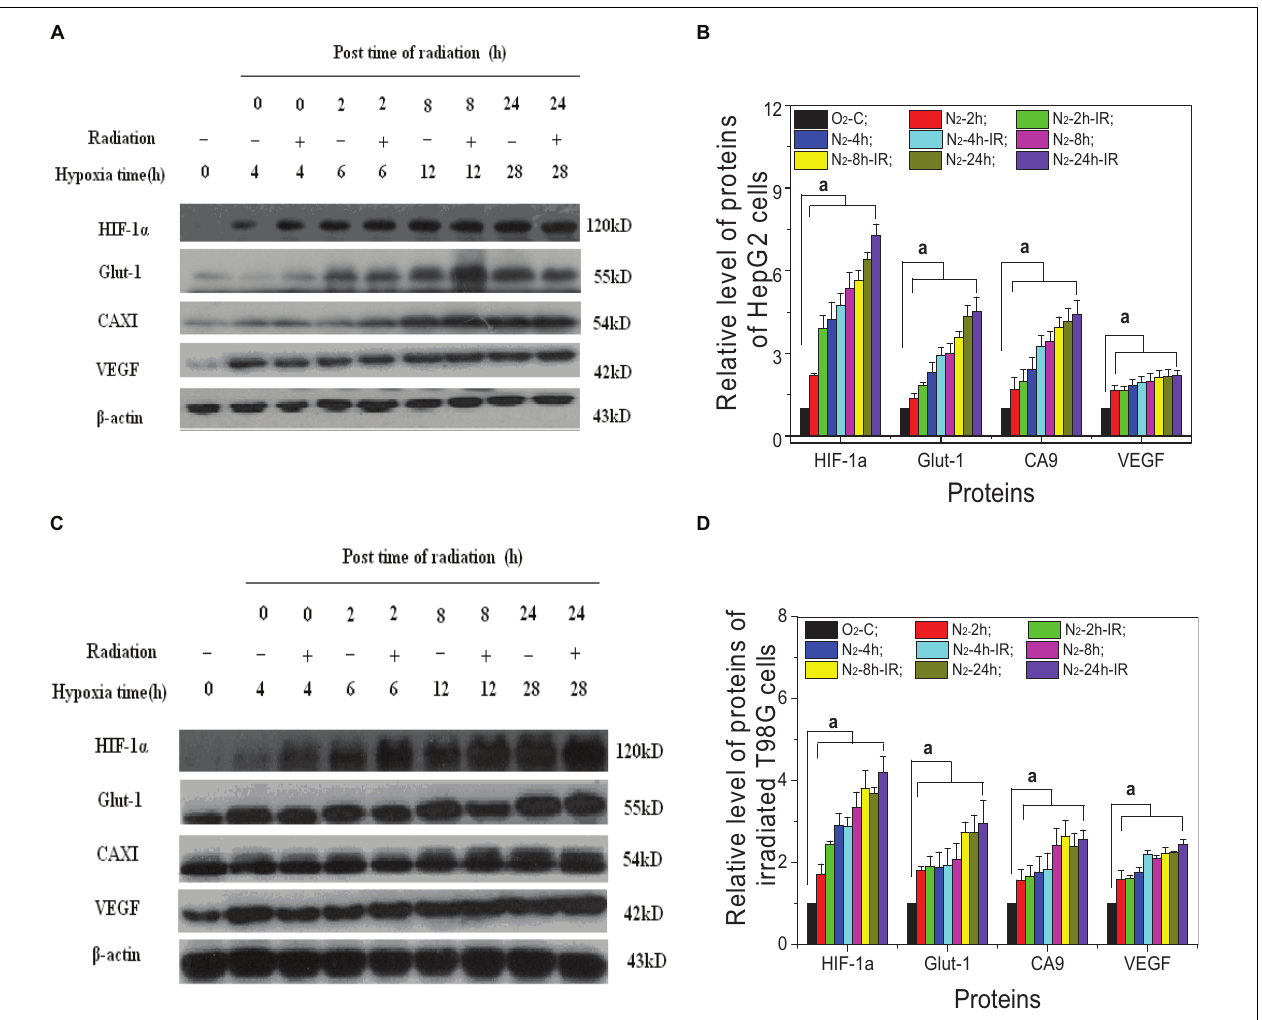
FIGURE 6 | Expression of HIF-1 α and its downstream proteins in irradiated hepatoma cells. Proteins were obtained from the two cell lines of HepG2 cells (A,B) and T98G cells (C,D) at 0, 2, 8, and 24 h post 5 Gy X-ray irradiation. The expression level of HIF-1 α and its downstream proteins was compared with the corresponding β -actin and then normalized to that protein from cells under normoxia conditions. a, p < 0.05, compared with the normoxic control in the absence of